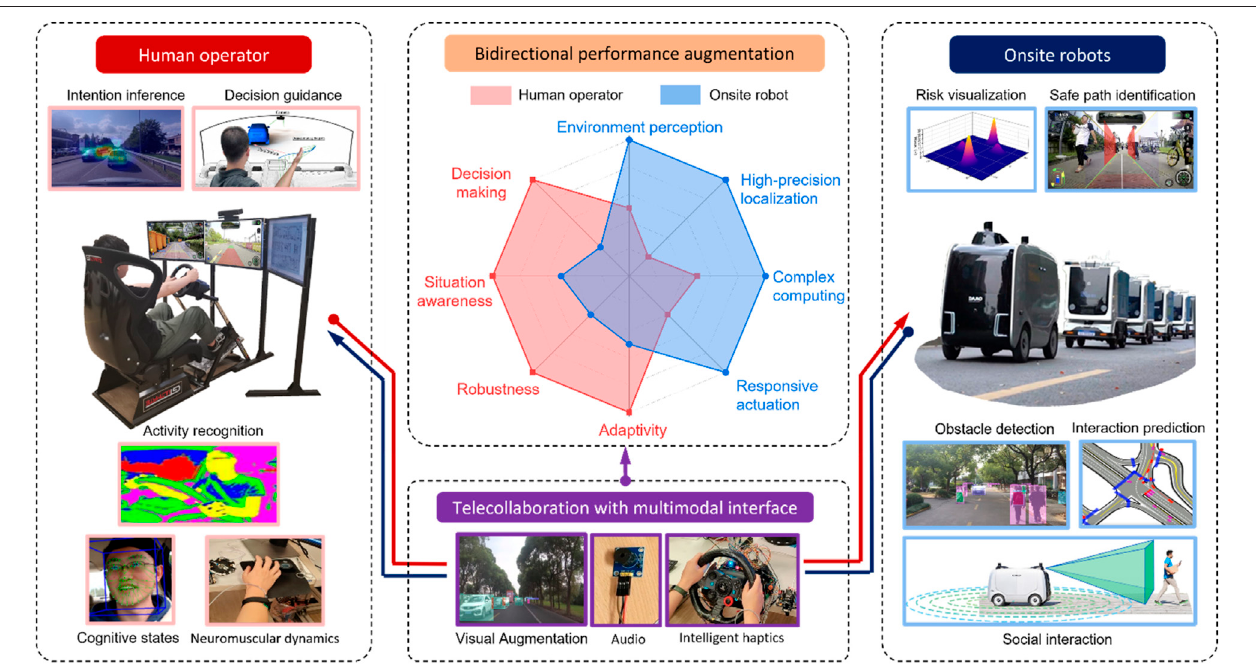
FIGURE 1 | The high-level architecture of the human – robot telecollaboration